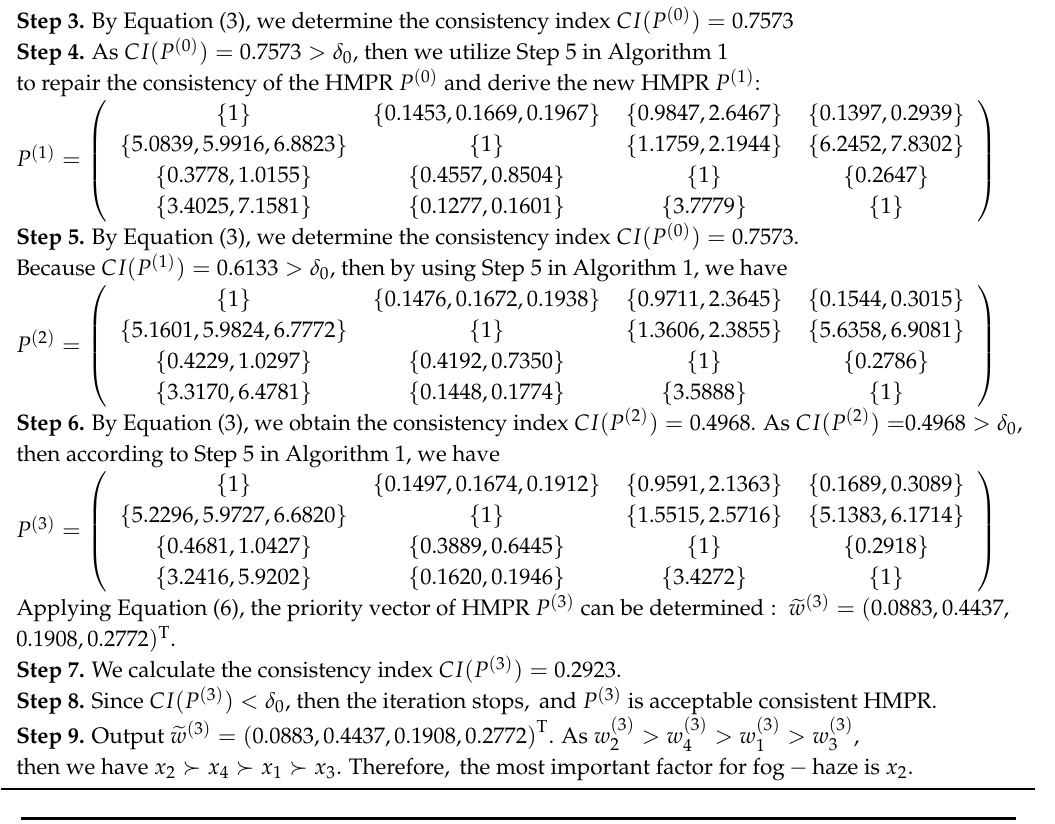
Algorithm 3: The consistency adjusting process of HMPR based on logarithm least squares model